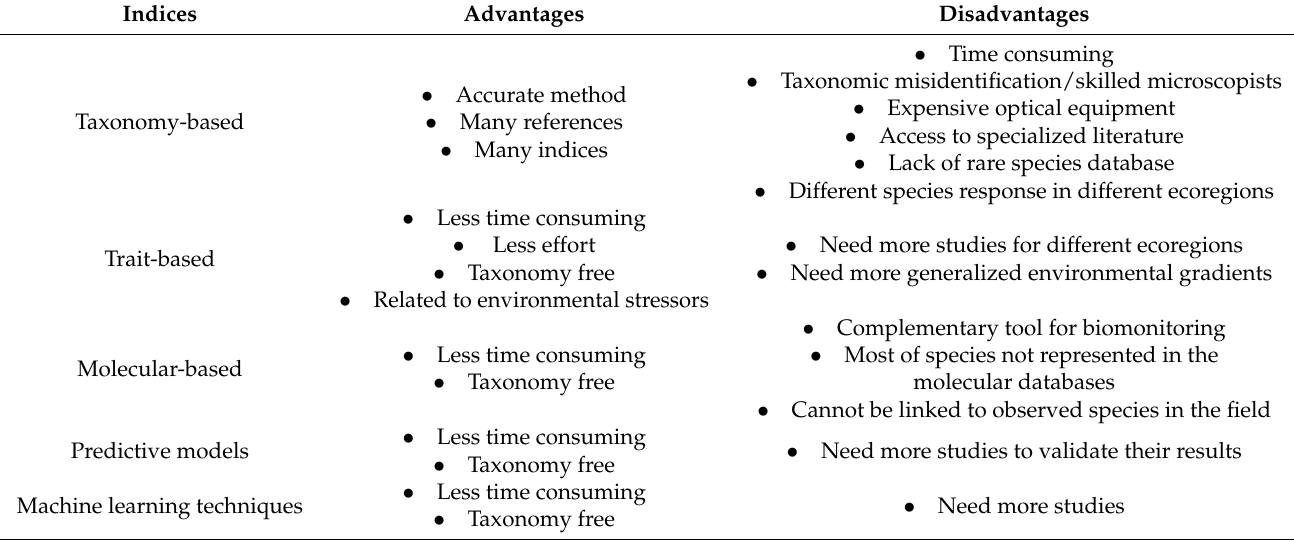
Table 3. Advantages and disadvantages of taxonomy-based diatom indices applied so far for water quality assessment and new promising